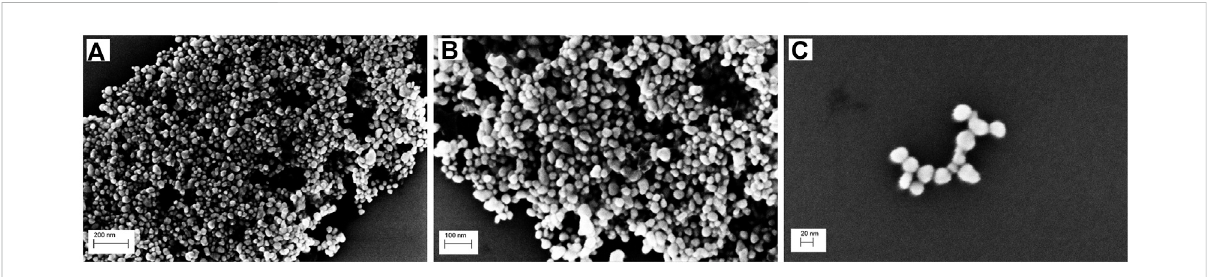
FIGURE 6 SEM image of the biosynthesized AgNP with different magni fi cations: (A) 200 nm, (B) 100 nm, (C) 20 nm.